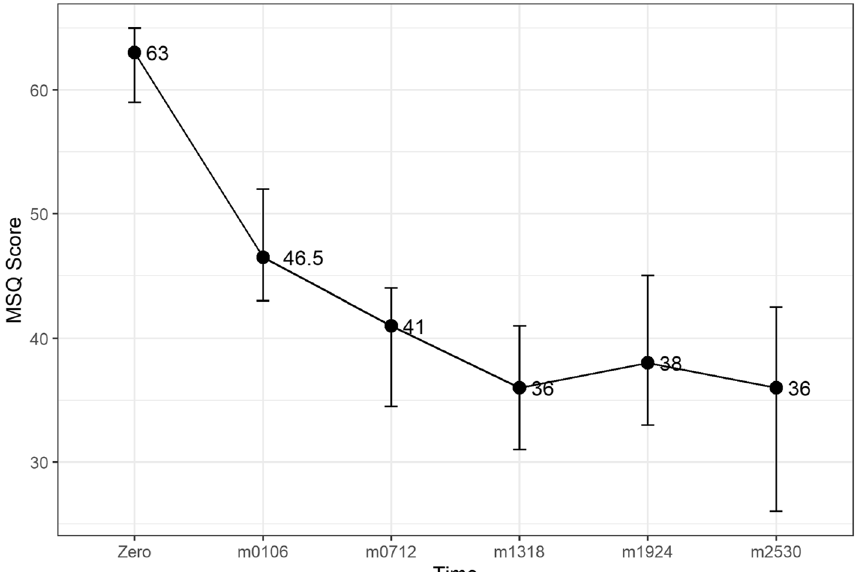
Fig. 3 Median MSQ score at baseline (y-axis) and up to 30 months of follow-up. Ninety-five percent confidence interval of median shown by vertical bars